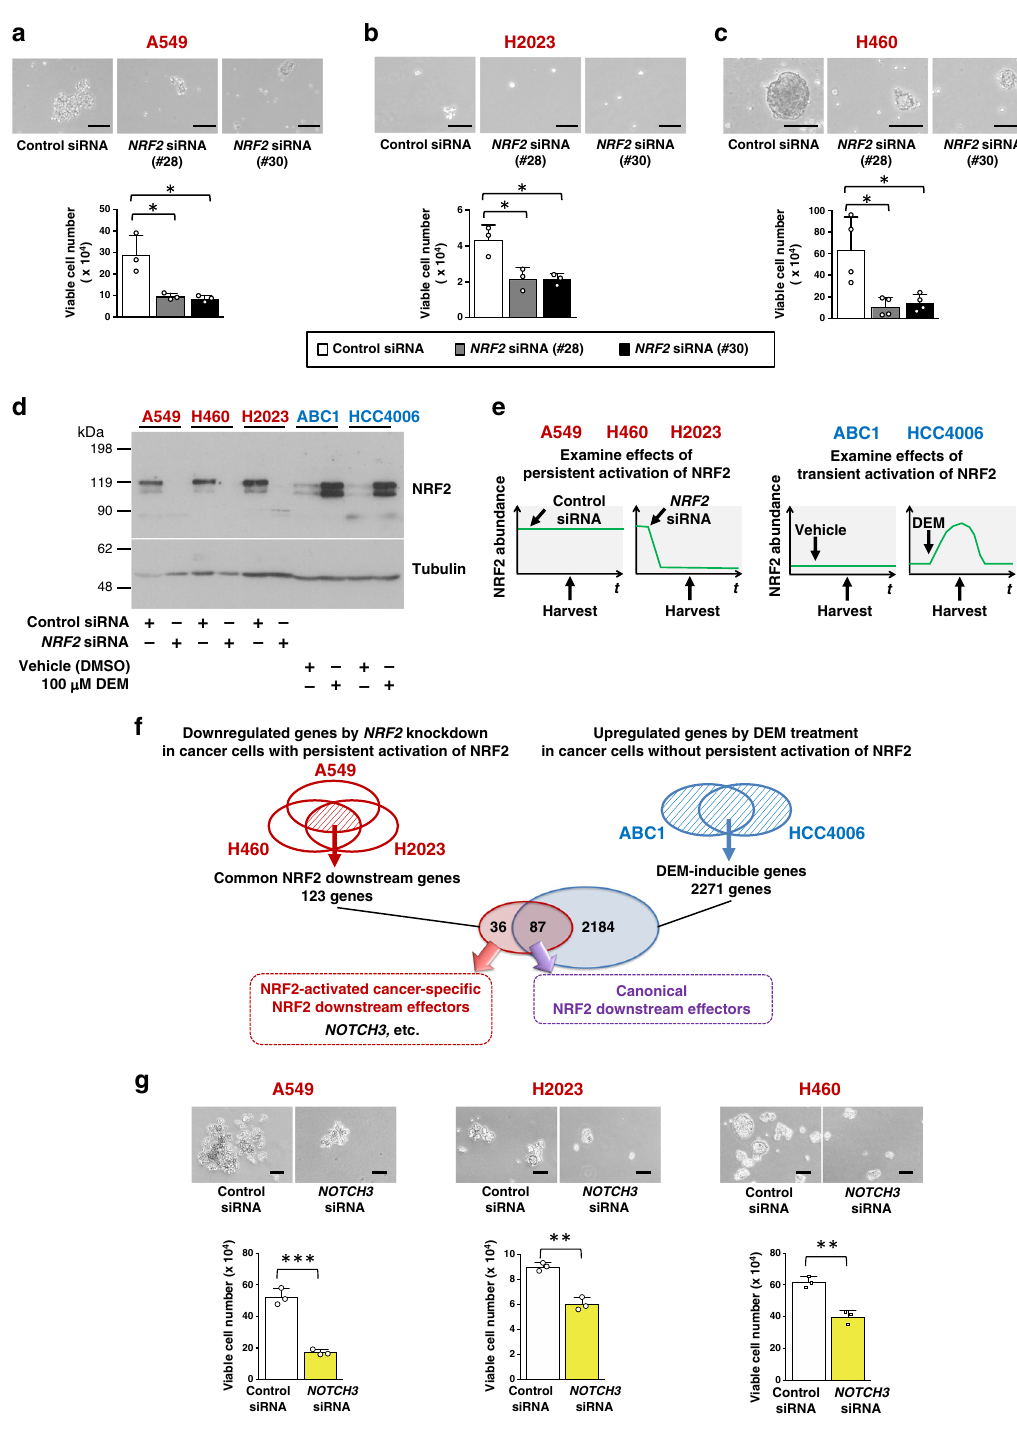
Fig. 1 NRF2 enhances tumor-initiating activity in NRF2-activated NSCLC cell lines. a – c Effects of NRF2 knockdown on the oncosphere formation of A549 ( a ), H2023 ( b ), and H460 ( c ) cells. Scale bars indicate 50, 20, and 100 μ m, respectively (top panels). Viable cells were counted after trypsinization (bottom panels). Average cell numbers and SD from 3 independent experiments are shown except for the experiment of H460 cells in c , which was independently conducted for four times. Comparison was made between two cell groups; control siRNA and each test siRNA. Two-sided Student ’ s t test was performed. * p < 0.05. d Immunoblot analysis of NRF2 protein levels in NSCLC cell lines. Tubulin was used as a loading control. One representative result of three independent experiments is shown. e Experimental design for the preparation of RNA samples from NRF2-activated (left panels) and NRF2- normal (right panels) NSCLC cells. f RNA-seq analysis of NSCLC cell lines. NRF2-activated (A549, H460, and H2023) and NRF2-normal (ABC1 and HCC4006) NSCLC cells were examined. In the following Figures, NRF2-activated and NRF2-normal NSCLC cells are indicated in red and blue, respectively. g Effects of NOTCH3 knockdown on the oncosphere formation of NRF2-activated NSCLC cells. Scale bars indicate 100 μ m (top panels). Viable cells were counted after trypsinization (bottom panels). Average cell numbers and SD from three independent experiments are shown. Two-sided Student ’ s t test was performed. ** p < 0.005, *** p < 0.0005. DMSO: dimethyl sulfoxide, DEM: